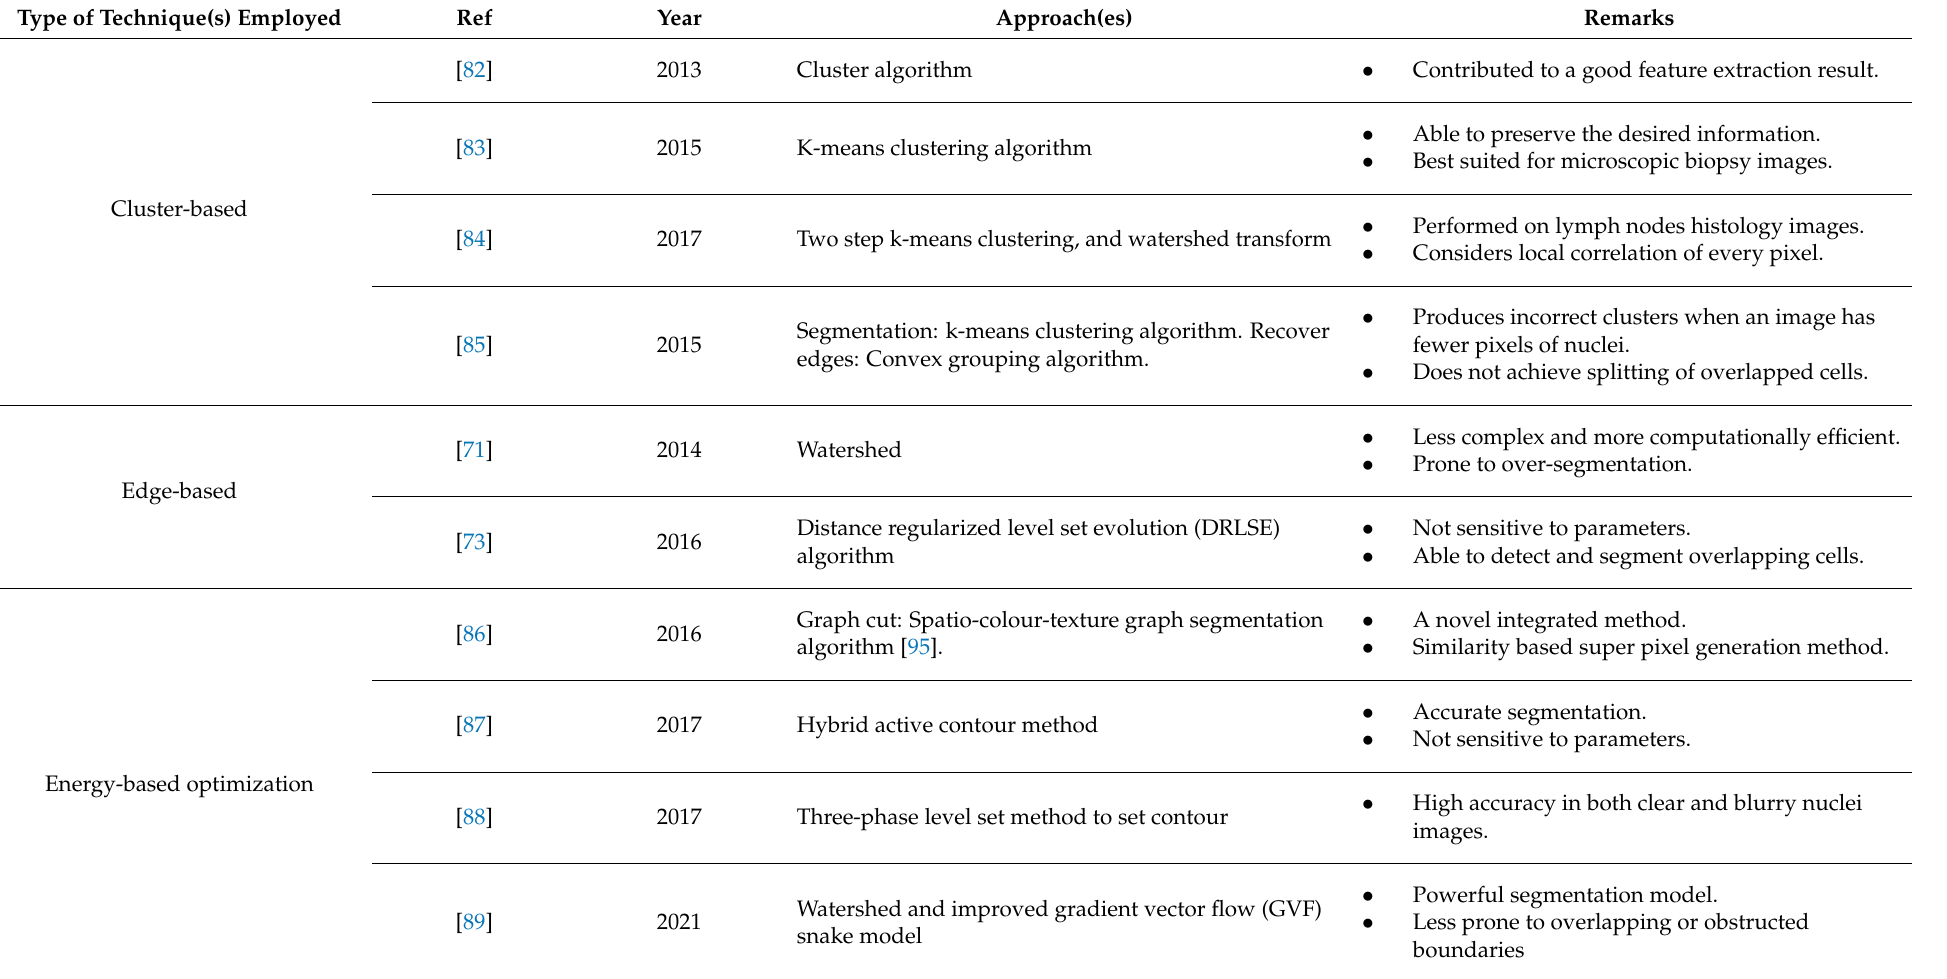
Table 5. Summary of different segmentation approaches by several